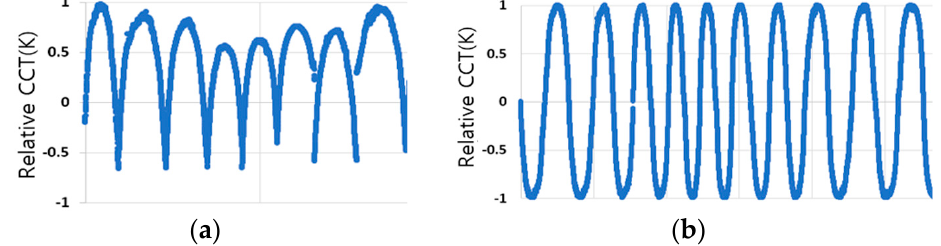
Figure 3. Learning dataset. ( a ) Initial learning dataset. ( b ) After applying inverse parabola padding.